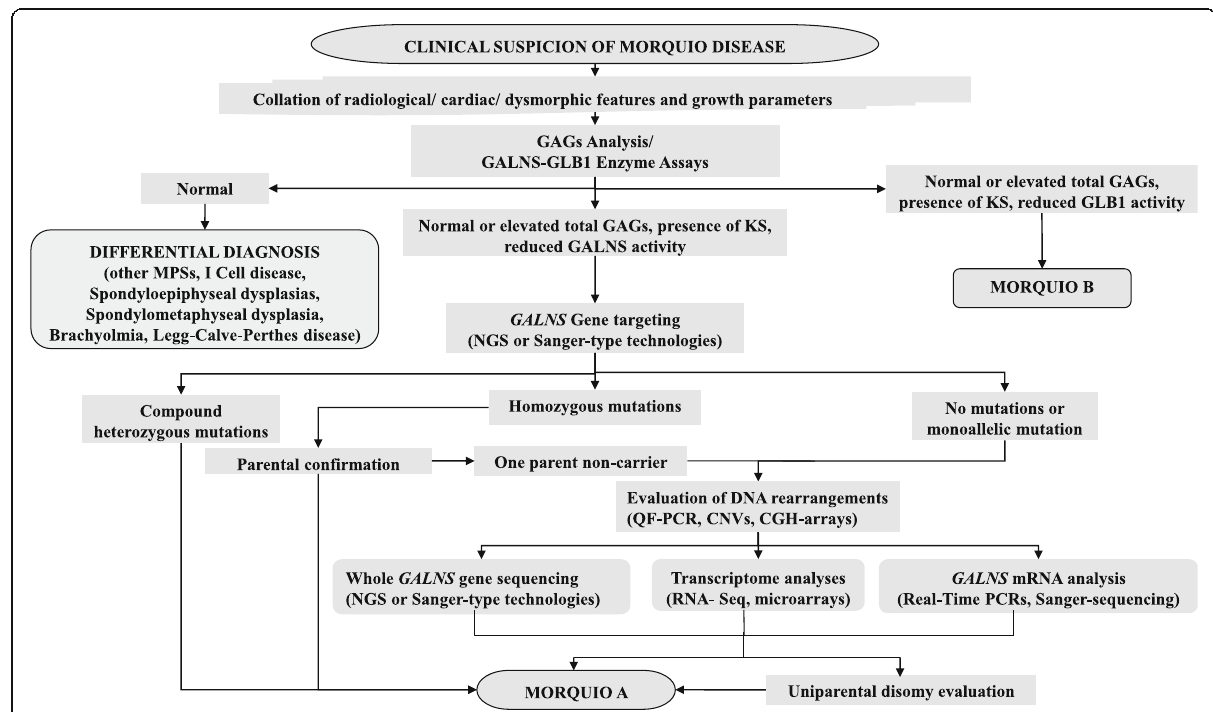
Fig. 1 Diagnostic flowchart for Morquio A disease. The flowchart illustrates our clinical/laboratory analytical procedure. It should be noted that the procedure includes mRNA analysis in addition to DNA and protein